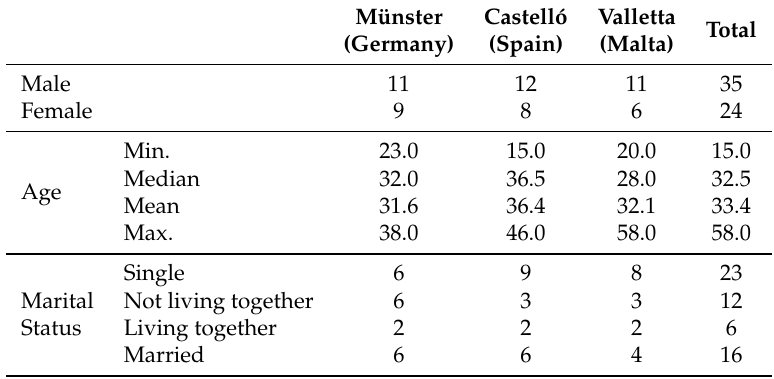
Table 1. Demographic information of